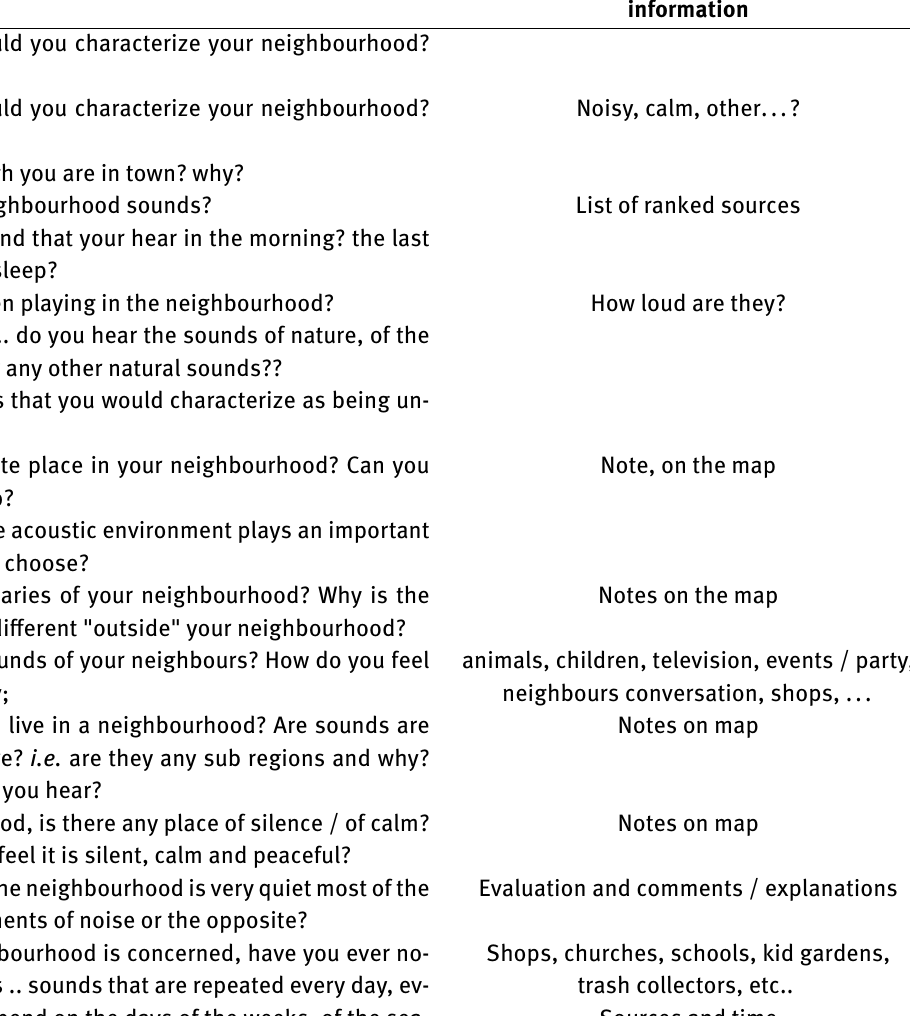
Table 3: General structure of the questionnaires used for the interviews.